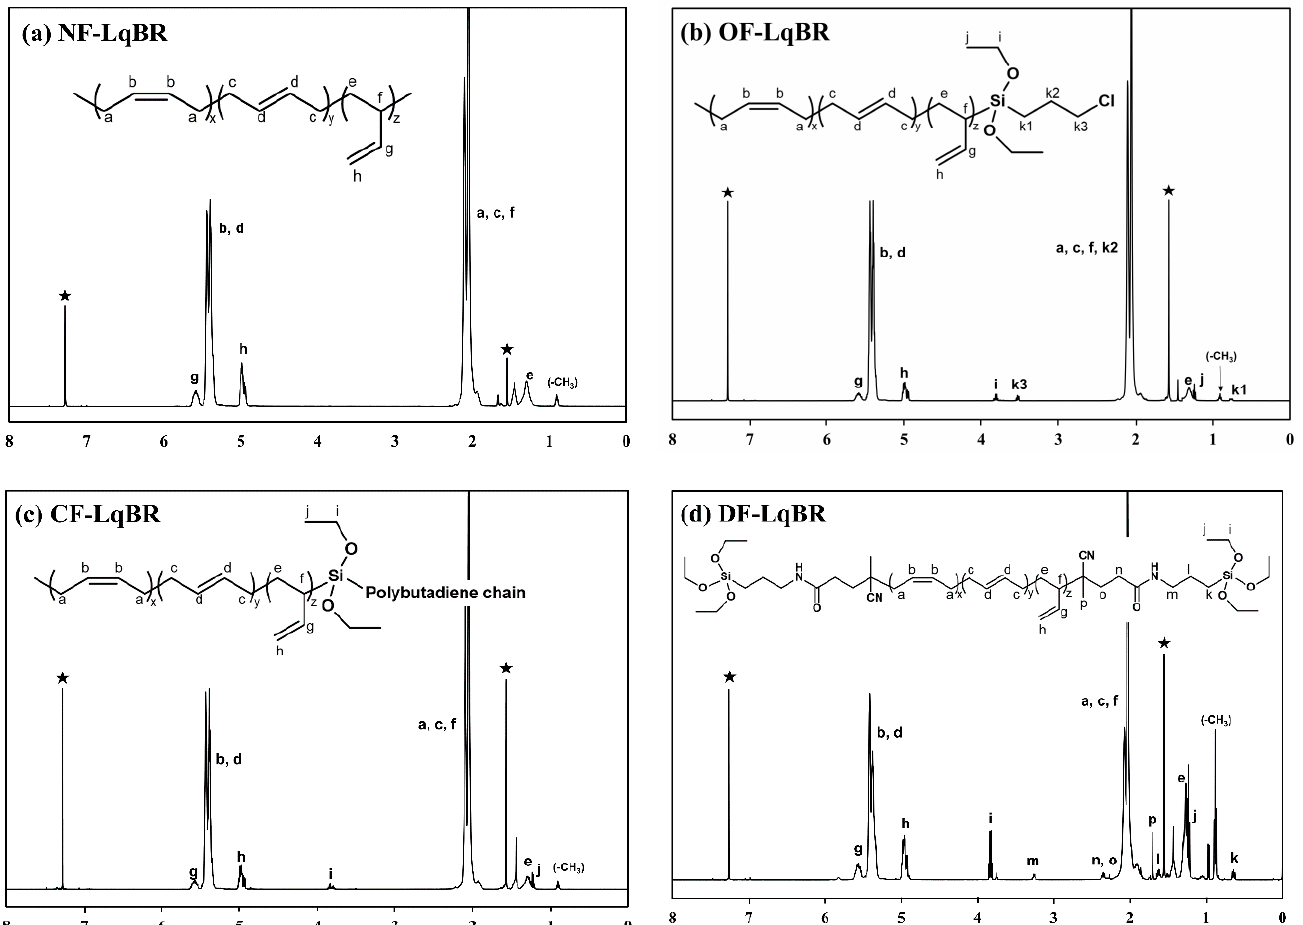
Figure 3. 1 H NMR spectra; ( a ) NF-LqBR, ( b ) OF-LqBR, ( c ) CF-LqBR, and ( d ) DF-LqBR ★ Resonance peak of CDCl 3 at 1.57 and 7.26 ppm; due to solvent impurities and residual H.